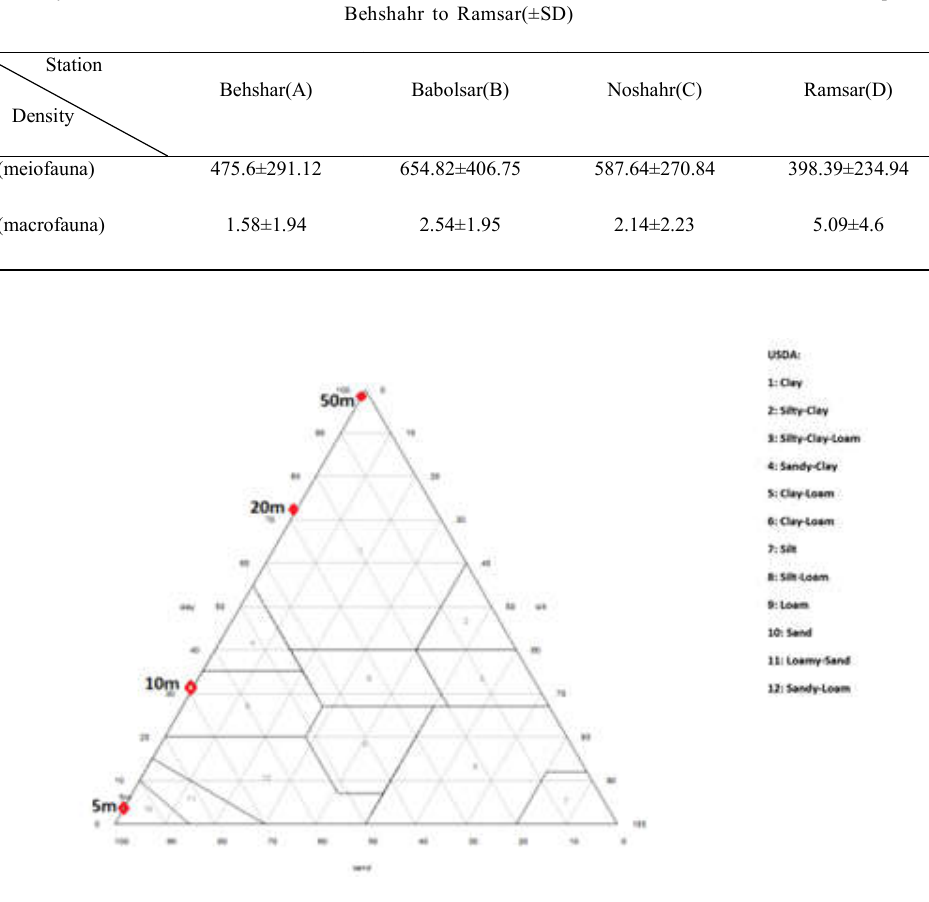
Fig. 2: percentage of grovel, sand and silt and clay in different depth in the southern Caspian Sea from Behshahr to